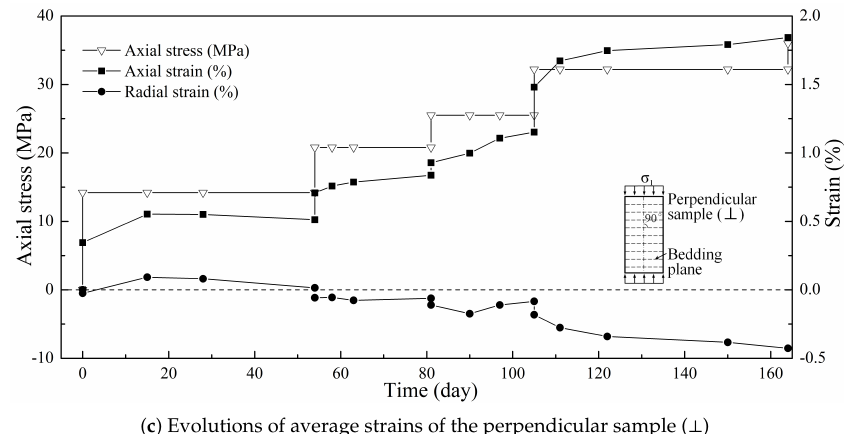
Figure 6. Evolutions of average axial and radial strains during In situ creep tests on three samples with di ff erent loading